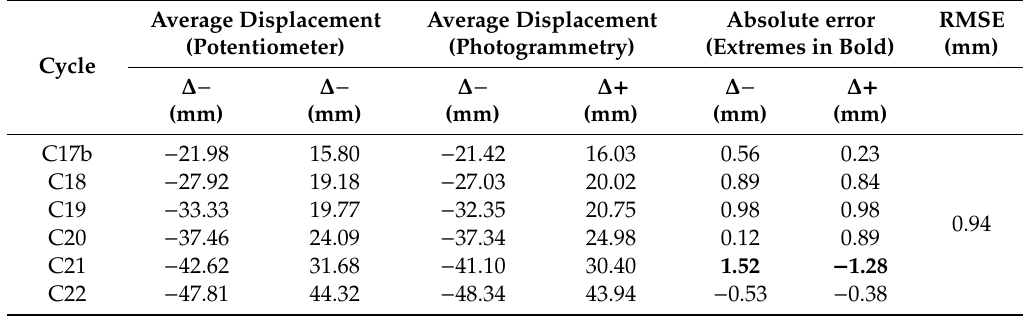
Table 7. Absolute errors obtained for the comparison between the average values of the peaks captured by target 1386 and sensor P1 after outlier removal. RMSE—root-mean-square error.